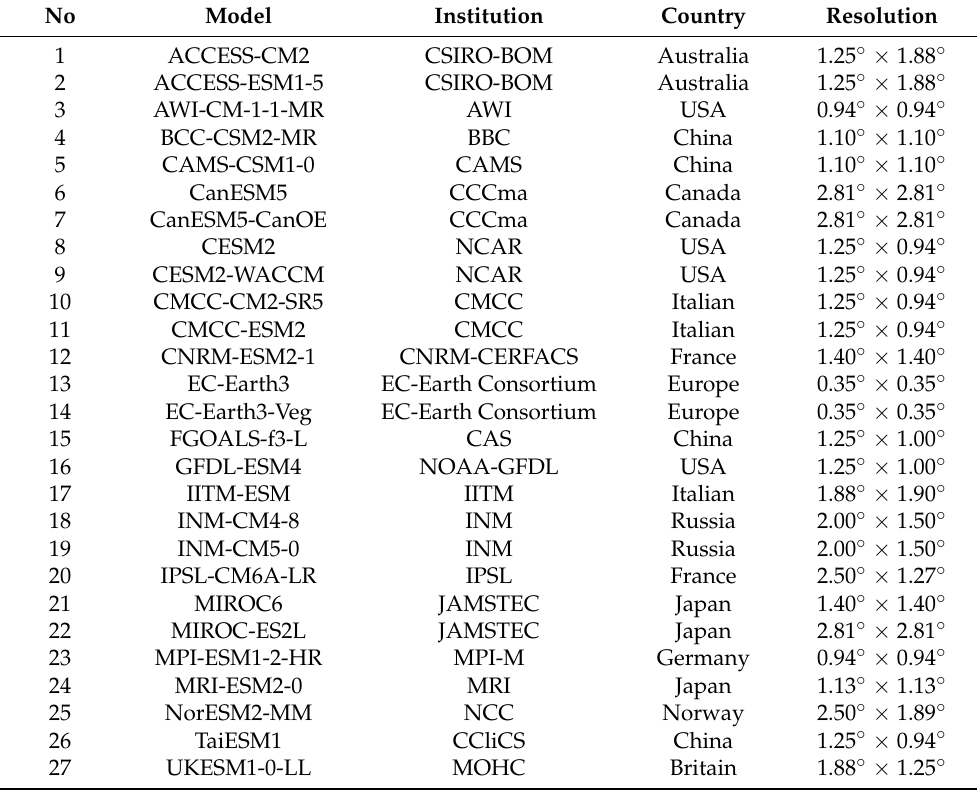
Table 1. Coupled Model Intercomparison Project (CMIP6) models adopted in this